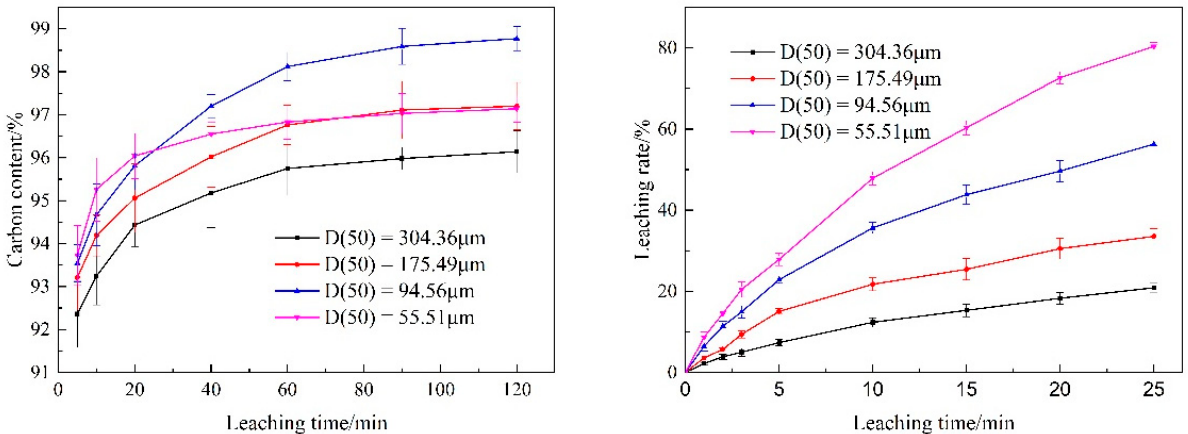
Figure 4. Effect of particle size on carbon content ( left ) and Al leching rate ( right ) (initial HCl con- concentration 4 mol/L, 333 K, NaF dosage 0.3 centration 4 mol/L, 333 K, NaF dosage 0.3 mol/L).